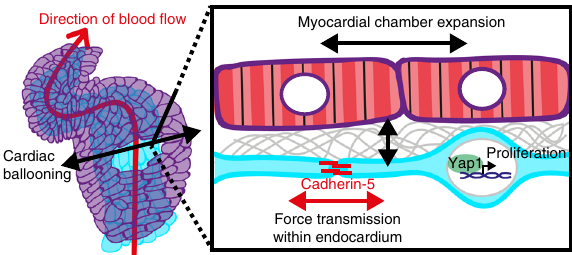
Fig. 7 Model of intra-organ communication within the developing zebra fi sh heart. Myocardial chamber expansion causes increased tensile forces within the endocardial cell junctions which are transmitted by